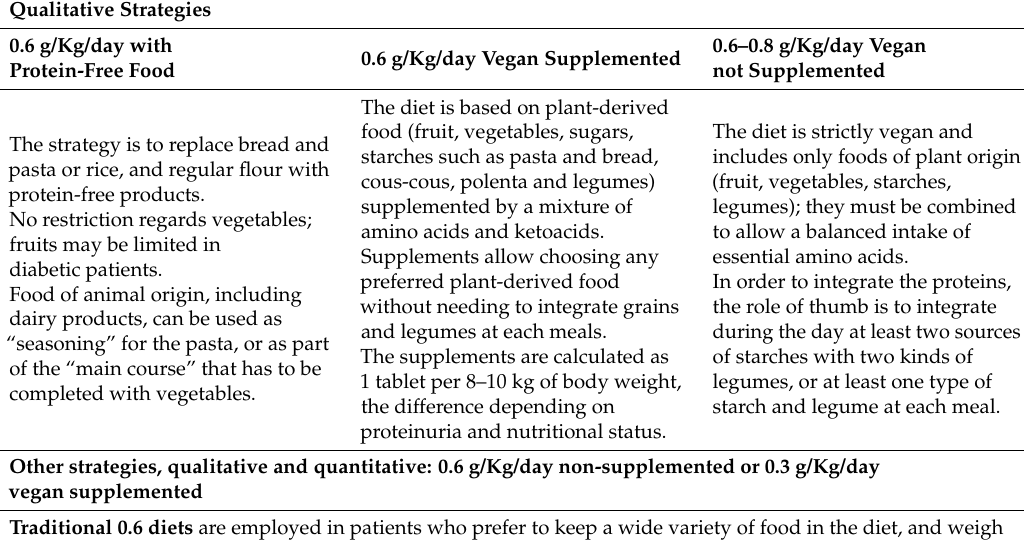
Table 1. The main diet